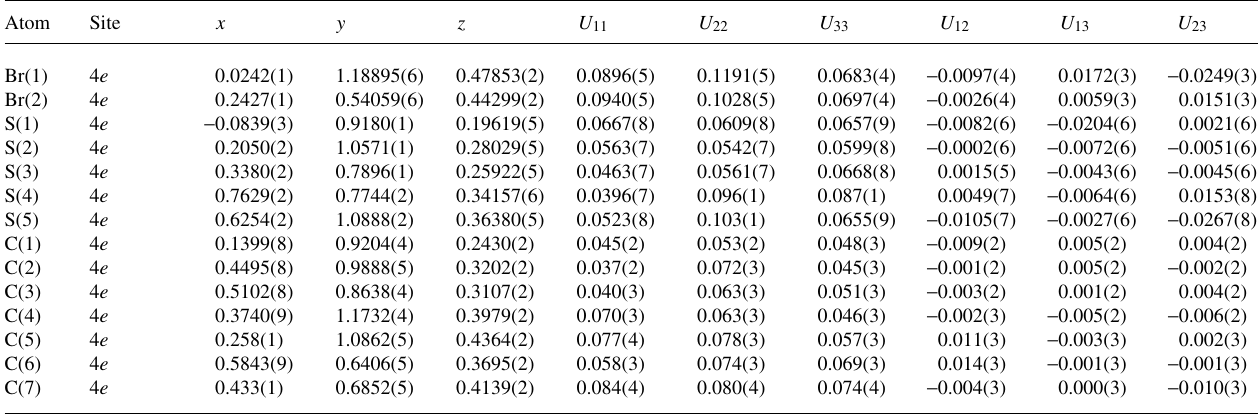
Table 3. Atomic coordinates and displacement parameters (in Å 2 )